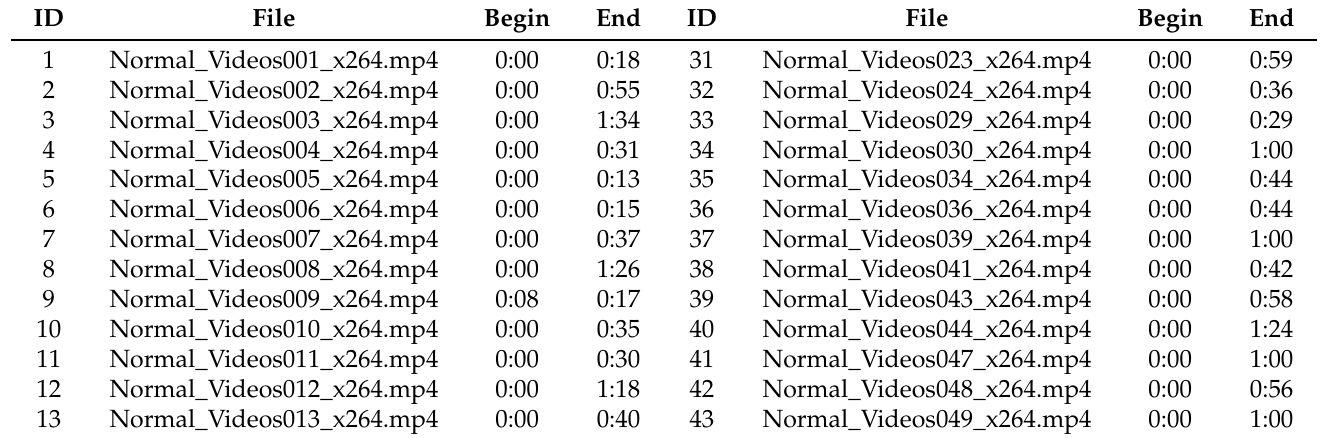
Table A1. List of normal behavior samples. Videos were taken from the UCF-Crime dataset